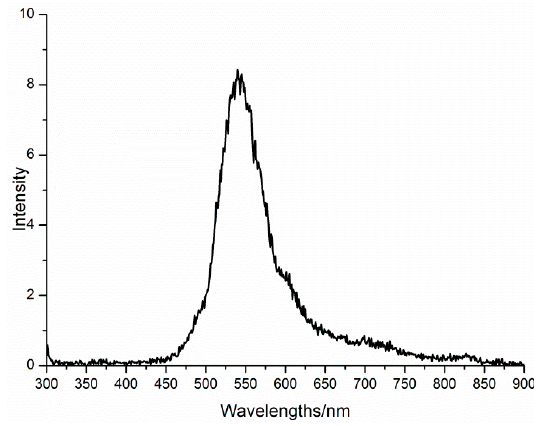
Figure 9. Emission spectrum ( λ ex = 275 nm) of Mn 4 -P 2 W 15 .